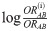
Scatter plots of logOR changes after and before excluding trials for the 20 networks.The x-axis labels changes obtained from the AB approach, i.e., logORAB(i)ORAB, while the y-axis labels changes obtained from the CB approach, i.e., logORCB(i)ORCB. Left panel pools results from the 20 networks with scatters deviating from the identity line in color. Right panel excerpts colored scatters.